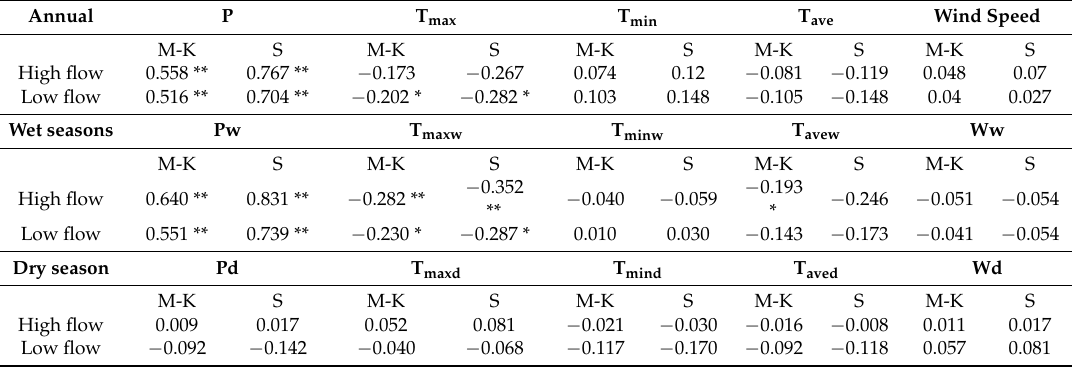
Table A1. Correlation analysis between hydrological variables and climate factors.